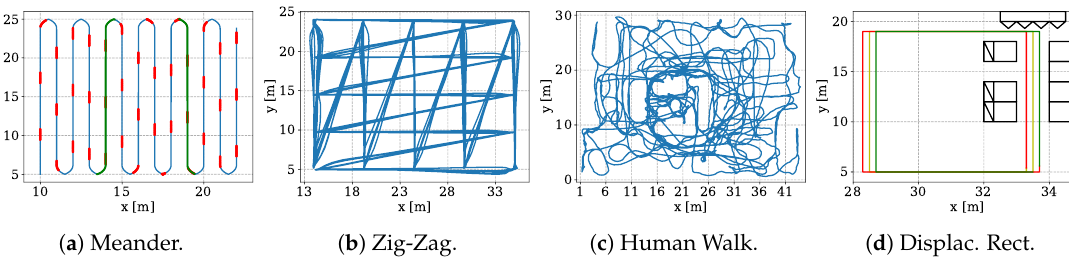
Figure 7. Datasets we use for our experiments [1]: Meander recorded with the positioning system; Zig-Zag recorded using the Segway RMP-210; Human Walk recorded using a human that builds up a construction in the test center; Displaced Rectangles recorded with the positioning system, see also Figure 6.